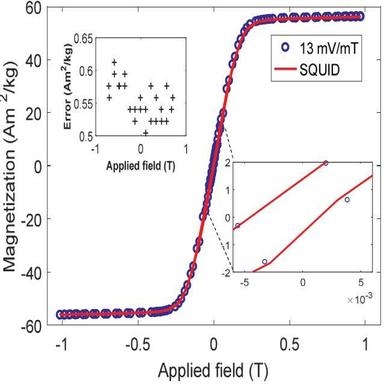
Comparison of the magnetisation curves of the Ni sphere measured with our Hall magnetometer in the 13 mV/mT sensitivity (circles) configuration and with a SQUID magnetometer (solid curve). The lower inset shows that the remanent magnetizations obtained by the two magnetometers differ by less than 0.5 A m2 /kg. The upper inset shows the difference between the SQUID and Hall results as a function of the applied field.